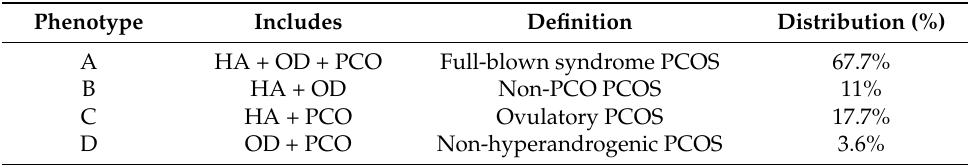
Table 1. Percentage distribution of phenotypes in PCOS patients